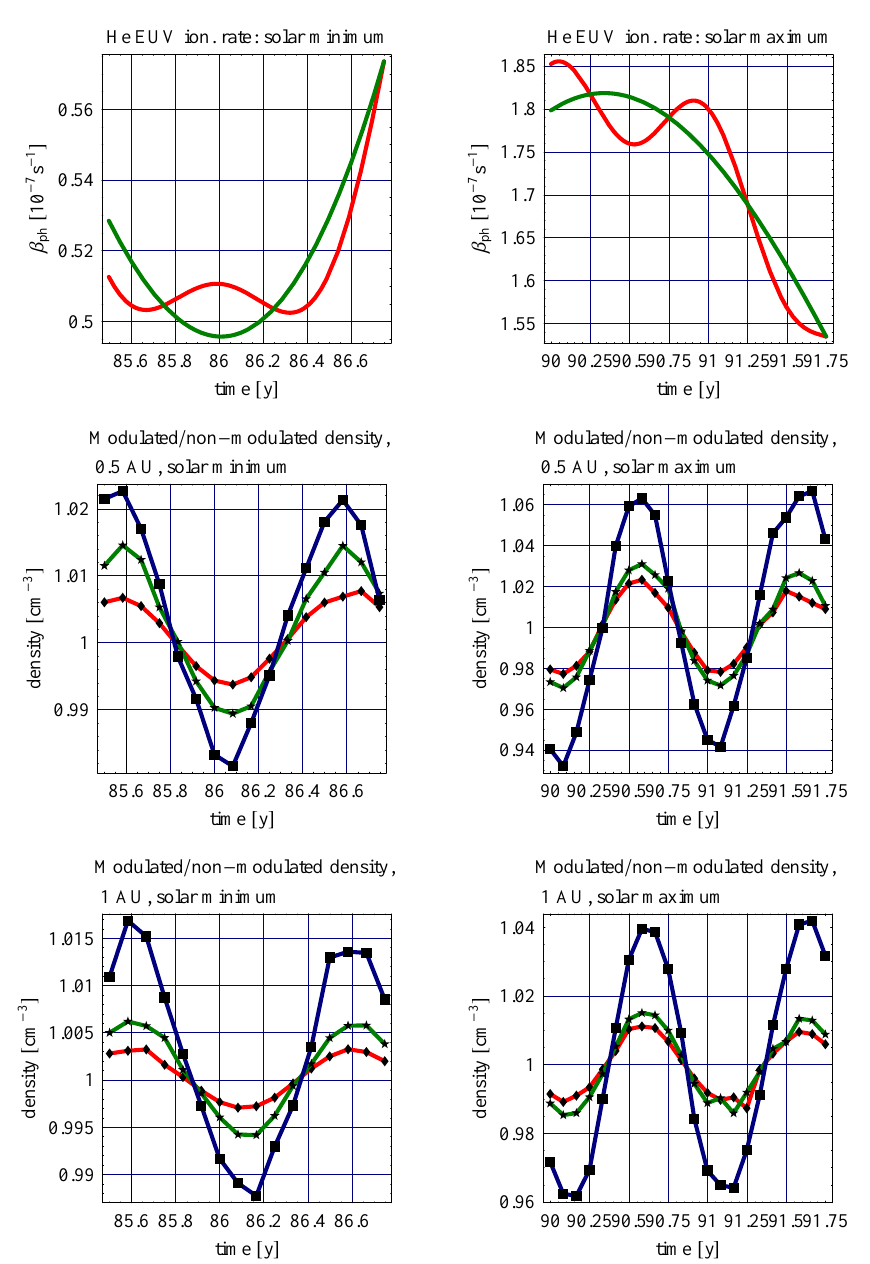
Fig. 10. Effects of small periodic fluctuations of ionization rate on helium density during solar minimum and maximum. Upper row: the modulated (red) and non-modulated ionization rates; the modulated rate is given by Eq. (10) and the non-modulated rate is presented in Fig. 1. Middle and lower rows: ratios of modulated to non-modulated densities at 0.5 AU from the Sun (middle row) and at 1.0 AU from the Sun (lower row). The red, green and blue lines in the two lower rows correspond to the upwind, crosswind, and downwind directions. The left-hand column is for solar minimum conditions and the right-hand column to the solar maximum conditions; times are indicated at the horizontal